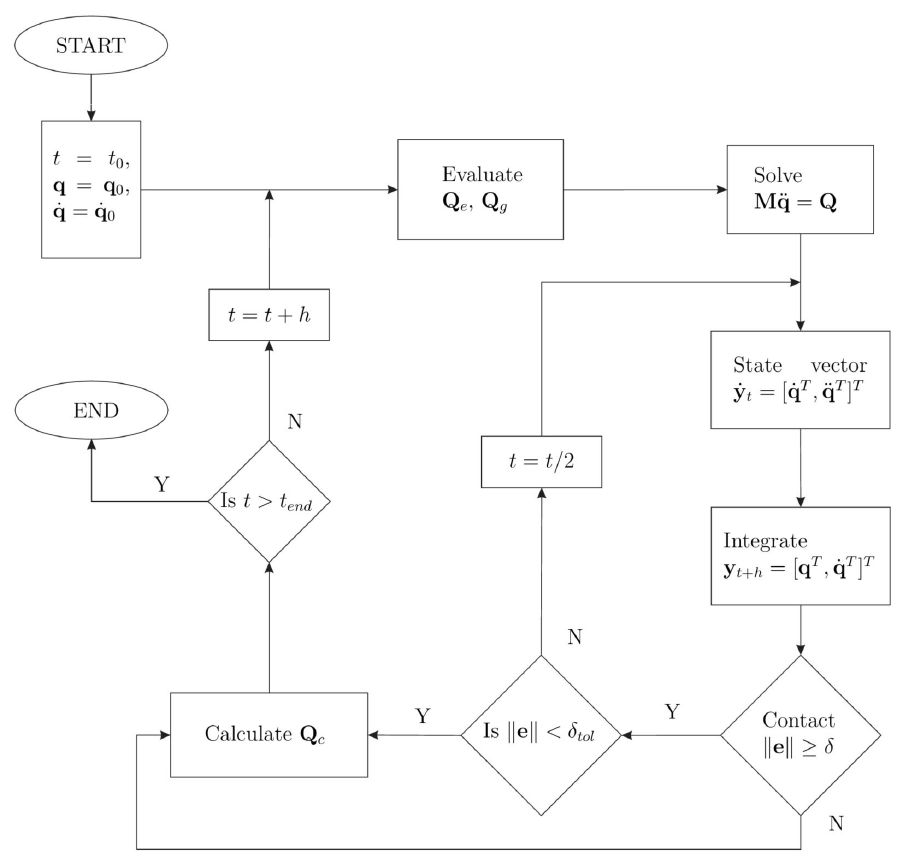
Figure 3. Flowchart of the event-driven